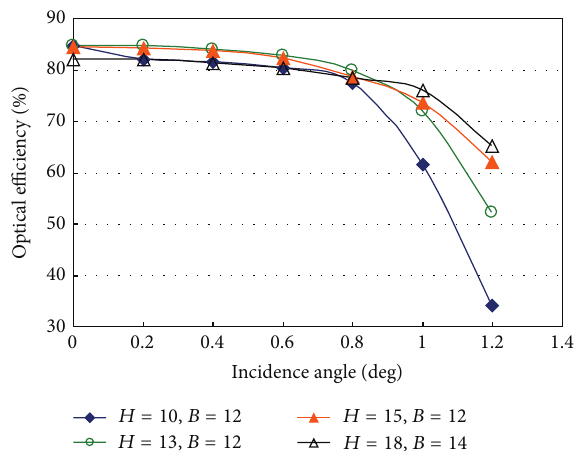
Figure 7: Optical efficiency with a refractive cone SOE under various incidence angles.